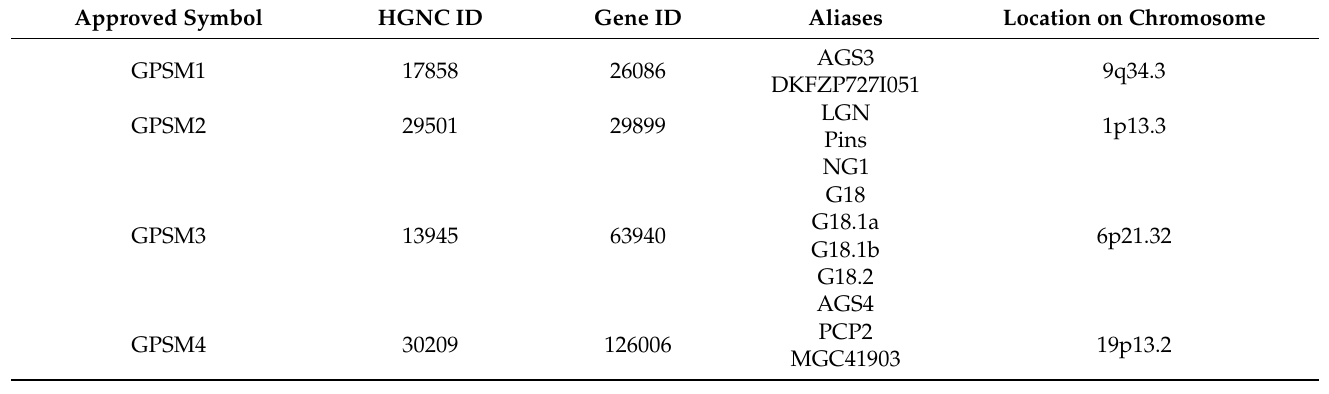
Table 1. Basic characteristics of GPSM family genes.